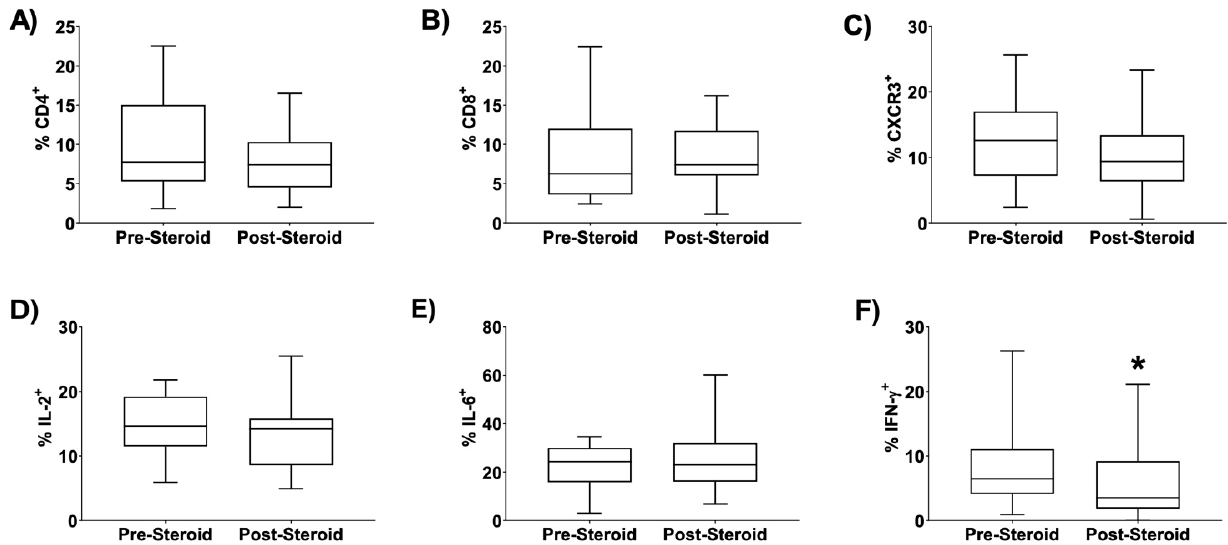
Figure 1. Effect of Dexamethasone on TA Cytokine Expression and T-Cell Composition ( A – F ). Dexamethasone significantly reduced tracheal aspirate (TA) IFN γ + cells. (Figure 1F, * p = 0.01), but not IL-2 + or IL-6 + cells), and did not affect T-cell composition when assessed by flow cytometry. Statistical analysis performed by two-tailed, paired Wilcoxon matched-pairs signed rank test, n = 14. Lines in the box and whisker plots represent the median, box extends from the 25th to 75th percentile, and the bars represent range.